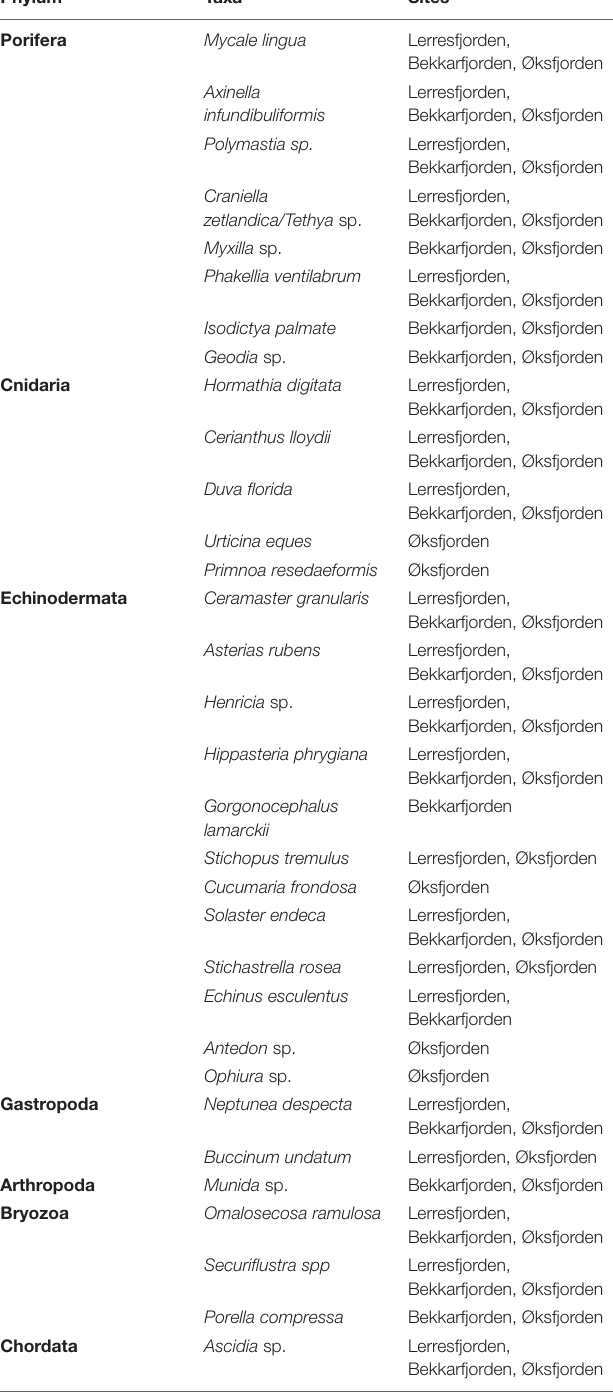
Table 6D ). At Klubbnesvika, epifaunal communities were at